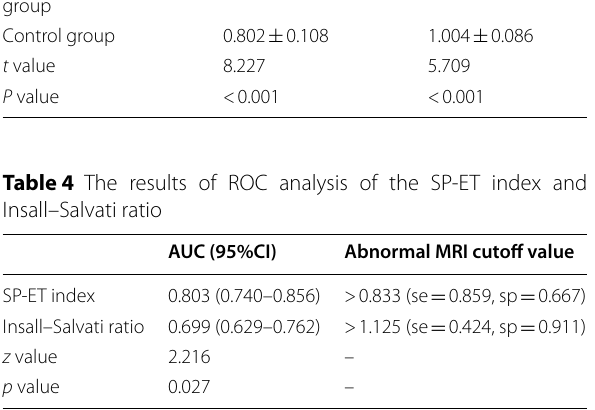
SP-ET index the most superior point of patella-entrance of femoral trochlea distance ratio, ICCs intraclass correlation coefficients, CI confidence interval